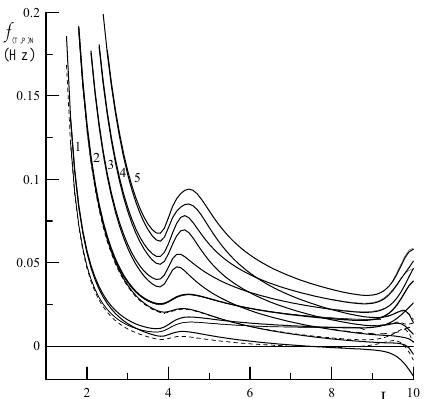
Fig. 4. Dependency of the toroidal (thick lines) and poloidal (thin lines) eigenfrequencies (cid:127) TN (x 1 ), (cid:127) PN (x 1 ) on the magnetic shell parameter L for the first five longitudinal harmonics ( N = 1 ,..., 5),